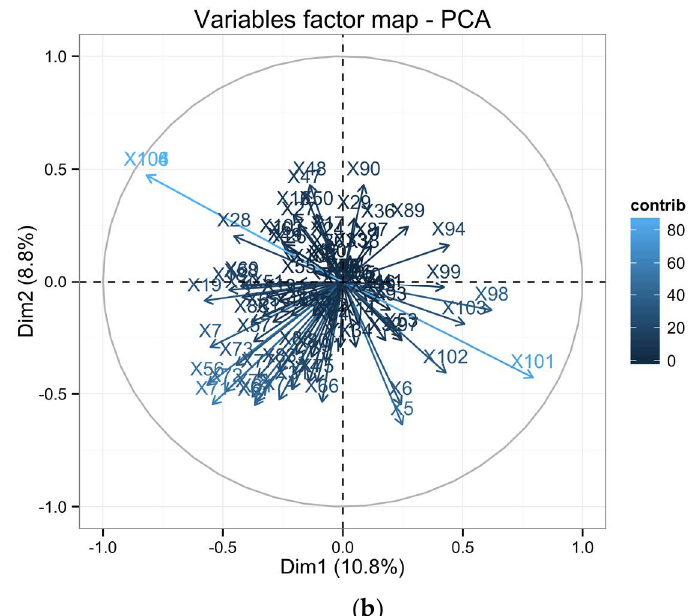
Figure 3. ( a ) PCA of Avicennia schaueriana individuals. RES—plants from restored area in Mauá Beach: REM—remnant plants in Mauá Beach; GUA—ESEC Guanabara; ARA—Araçá Bay. ( b ) Graphic showing the contribution of each ISSR loci in the PCA of A. schaueriana individuals. The legend shows a gradient color map from blue (no contribution) to red (high contribution).